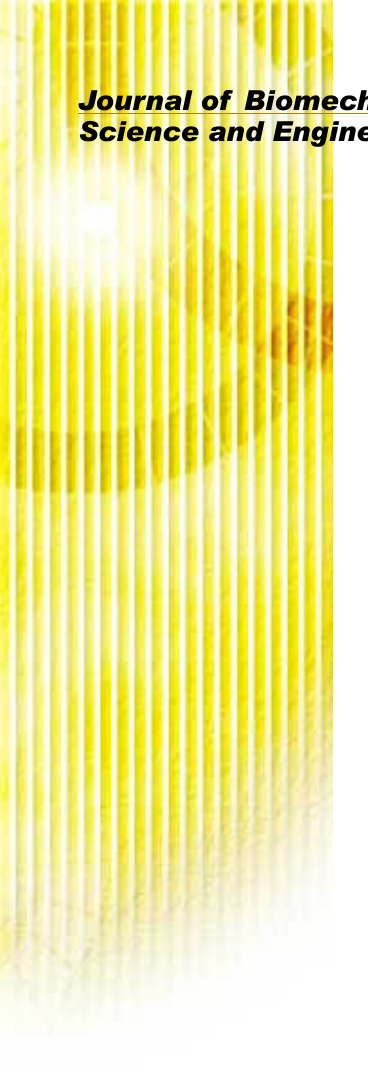
Fig. 16 Change in the adhesive strength over time for mussels D, E, F, and G.